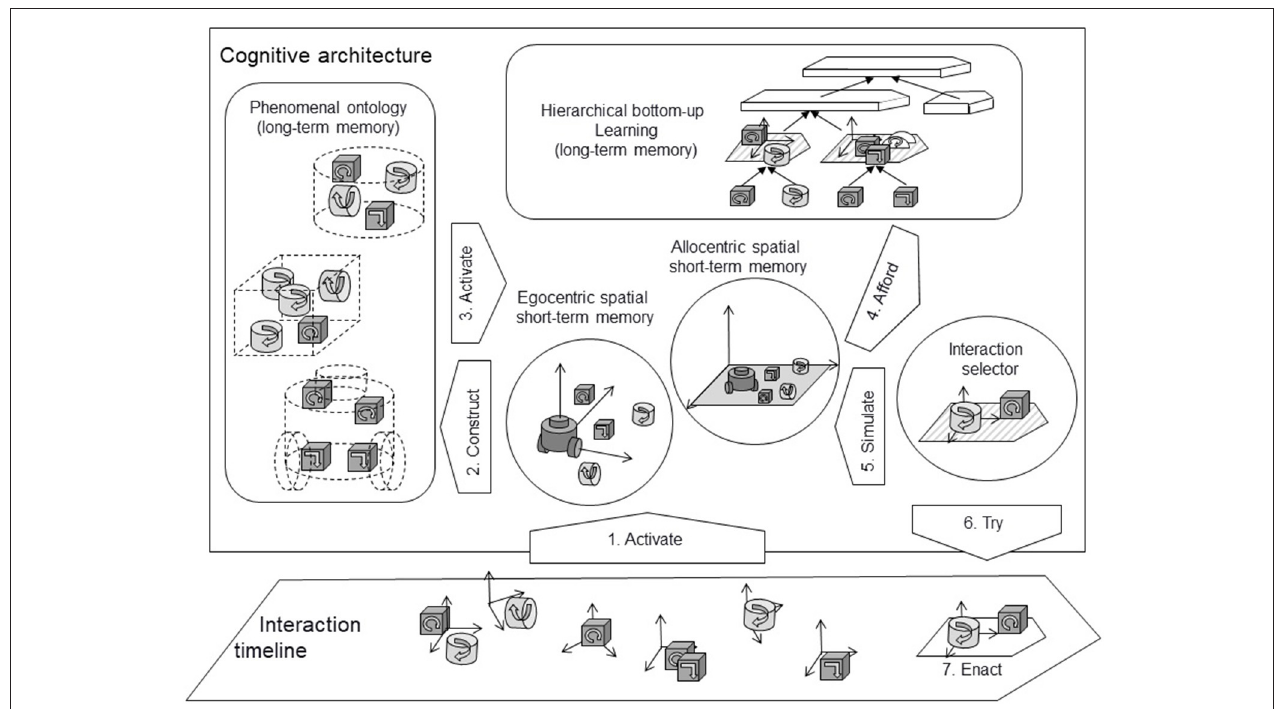
FIGURE 2 | Interactionist cognitive architecture (adapted from Georgeon et al., 2020). As in Figure 1 , interactions are represented as 3D blocks along a timeline to highlight the fact that they carry 3D spatial and temporal information. The interaction timeline (bottom) represents interactions as the robot experiences them over time. The cognitive architecture incorporates a hierarchical learning module (top right), different kinds of spatial memories (egocentric and allocentric) used to localize and track the position of interactions (center), and the phenomenal ontology (left) which stores categories of phenomena (objects as they appear through interaction) defined by the interactions that they afford. Enacted interactions activate (1) representations of the context in spatial and temporal memory. Phenomenal representations of objects are progressively constructed (2). When an object is recognized, the interactions that it affords can be activated (3) in spatial memory. The spatial representation of the context affords (4) subsequent composite interactions. In return, afforded interactions can be simulated (5) in spatial memory. The policy 5 selects a new interaction, and the robot tries (6) to enact it